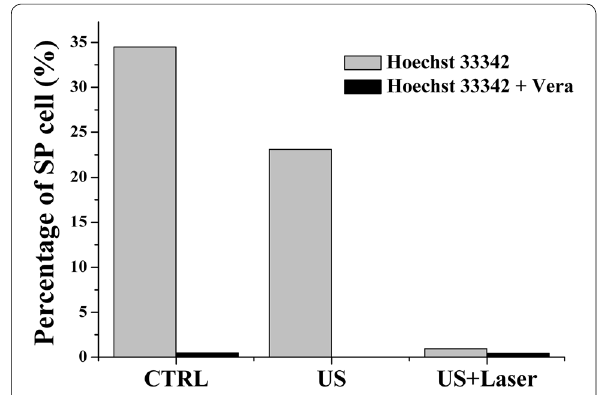
Fig. 6 Side population analysis. Image cytometry data showing percentage of side population MCF-7/ADR cells after treatment with DOX-NPs/Ce6-MBs, followed by US or US